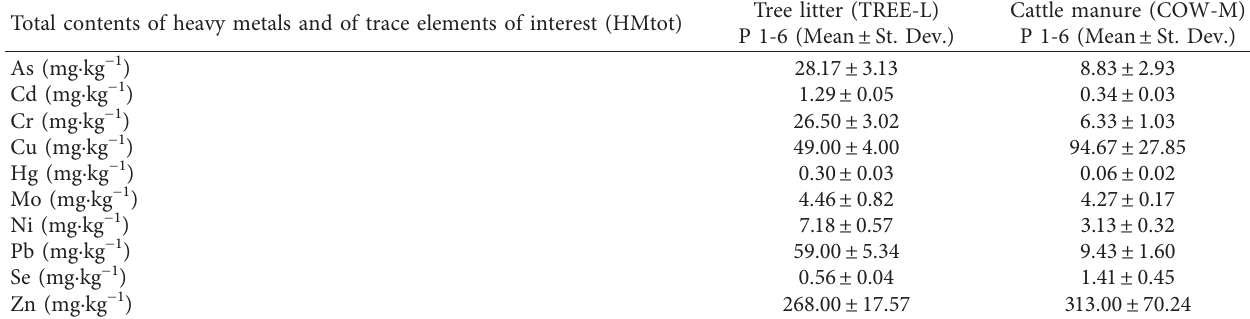
Table 3: Heavy metals and trace elements of interest of the raw materials used in the evaluation stage composting ( n � 6). Tree litter (TREE-L) Cattle manure Total contents of heavy metals and of trace elements of interest (HMtot)